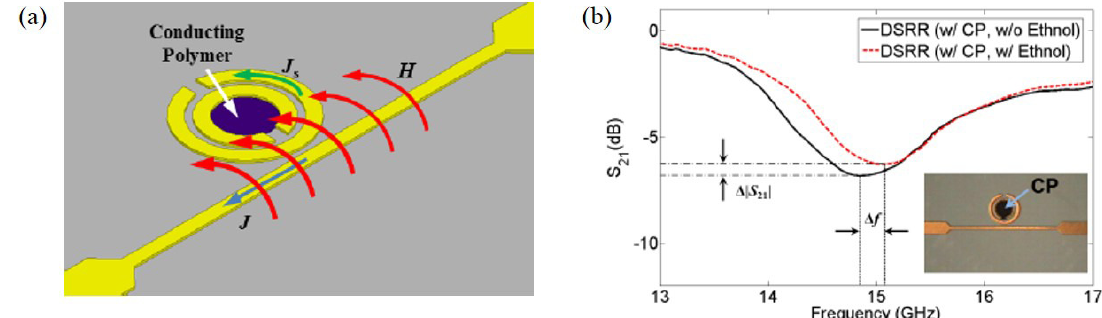
Figure 11. Ethanol gas sensor with DSRR and PEDOT:PSS. ( a ) Operation mechanism of the DSRR for gas detection using conducting polymer. ( b ) Transmission coefficients of the sensor with and without ethanol gas